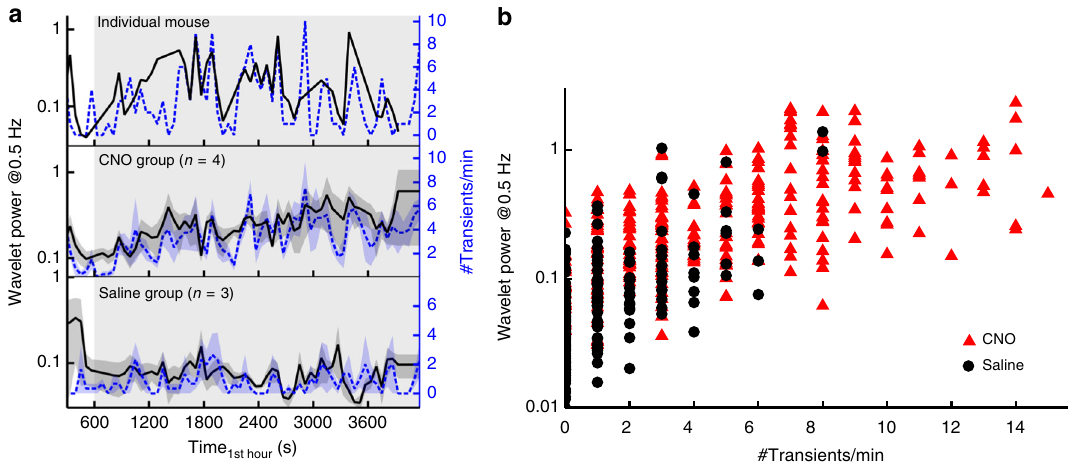
Fig. 7 FSCV wavelet power at 0.5 Hz and transient rates in chemogenetically stimulated mice. a Comparison of the number of transients per minute (blue dashed lines) and the wavelet power at 0.5 Hz (black lines) calculated from continuously recorded FSCV data in one individual example mouse and in the CNO and Saline group (mean±SEM). The gray box indicates the time after CNO/ Saline injection. b Correlation of transient rate with the logarithm of the wavelet power at 0.5 Hz from all mice (red triangles = hM3D Gq DAT + CNO, n CNO = 4; black circles = hM3D Gq DAT + Saline, n Saline = 3; Pearson product moment correlations: r CNO = 0.64, p CNO <10 – 16 , df CNO = 296, t CNO = 14.26, r Saline = 0.63, p Saline <10 – 16 , df Saline = 215, t Saline = 11.75, r combined = 0.73, p combined <10 – 16 , df combined = 513, t combined =